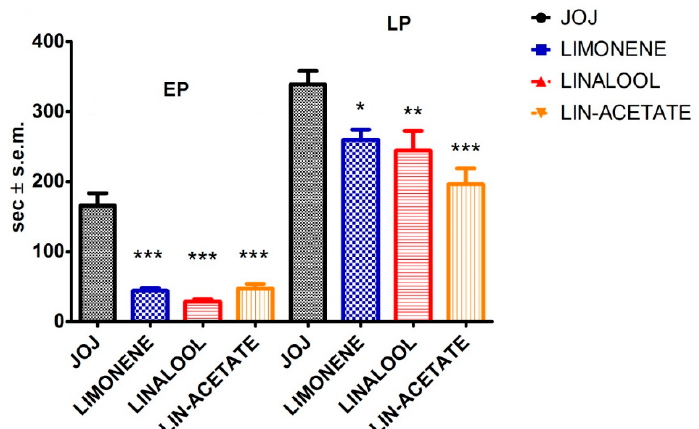
Figure 5. Analgesic effect of D -limonene, linalool and linalyl acetate on licking/biting behavior in the formalin test. The main pharmacologically active components of the volatile fraction of the essential oil of bergamot ( D -limonene, linalool, and linalyl acetate), transdermally administered immediately after formalin injection, significantly decreased the licking/biting time in the early and in the late phase (EP, LP) of the formalin test. All these constituents were almost equally effective in the EP, while linalyl acetate was the most active followed by linalool and limonene in the LP. Overall licking/biting time is expressed as time in s ± SEM during the EP (0–10 min) and the LP (10–30 min). One-way ANOVA followed by Bonferroni test; n = 8; * p < 0.05, ** p < 0.01, *** p < 0.001.